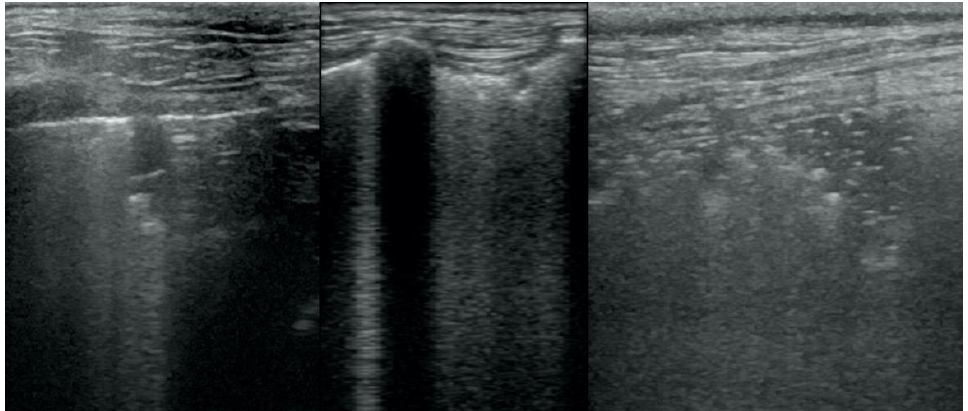
Figure 3. Subpleural consolidations in the course of pneumonia.